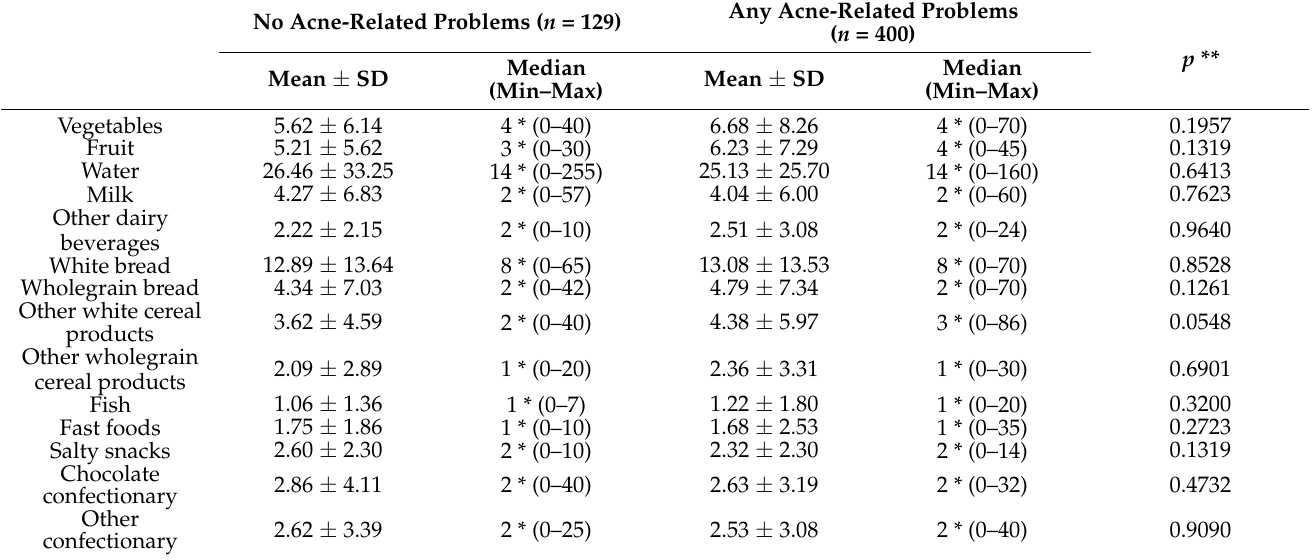
Table 7. Analysis of the difference of dietary intake between male adolescent participants of the study declaring no acne-related quality of life problems and any acne-related quality of life problems within any question of the Acne Disability Questionnaire